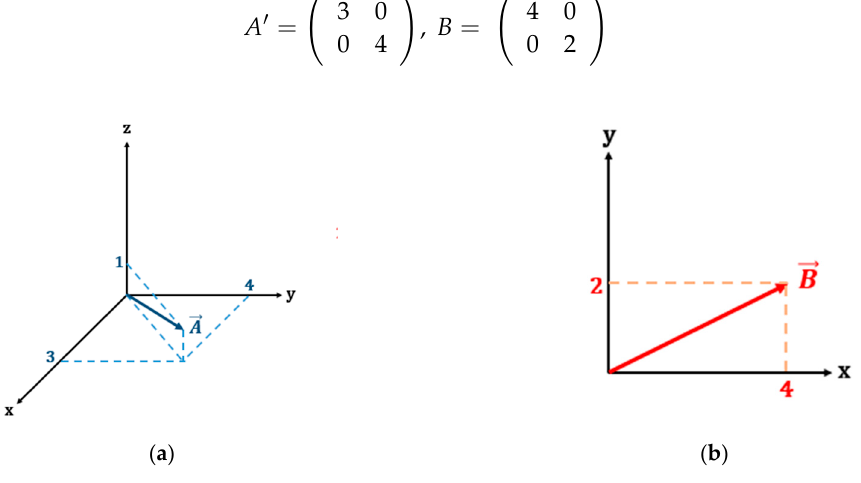
Figure 3. Vector of ( a ) diagonal A, and ( b ) diagonal B.